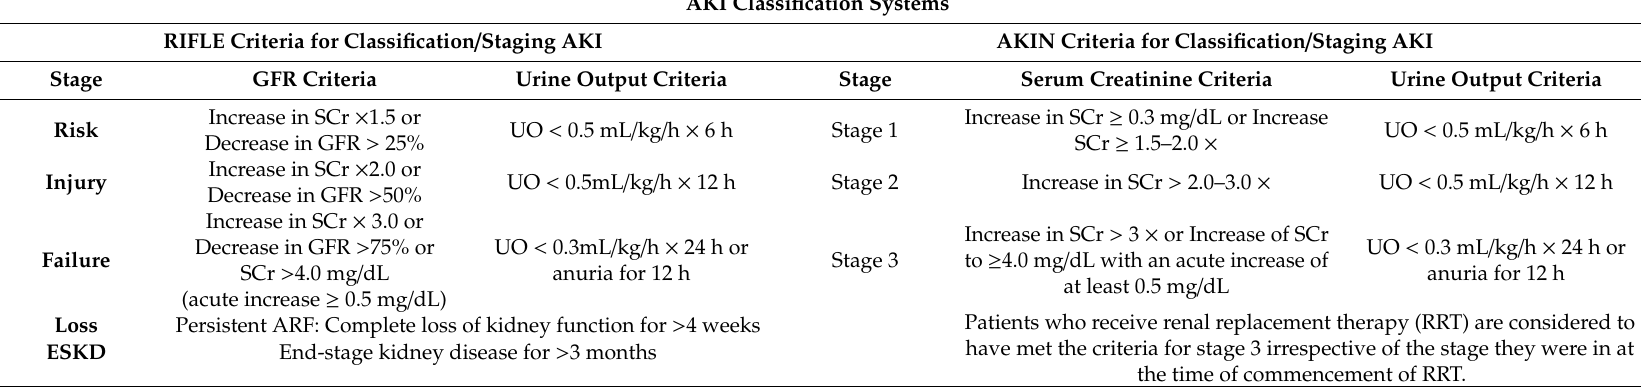
Table 3. Risk, injury, failure, loss (RIFLE) system classification for acute kidney injury (AKI) and the modifications of the AKI classification criteria proposed by the Acute Kidney Injury Network (AKIN) network (adapted from references [16,33,36].